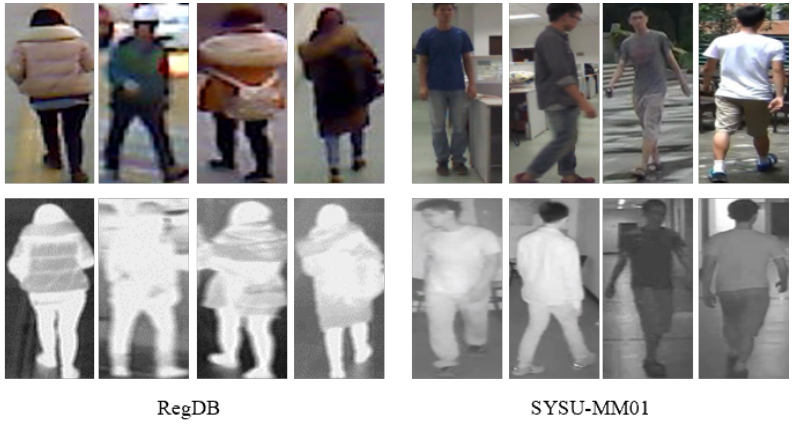
Figure 8. Pedestrian image samples derived from RegDB [78] and SYSU-MM01 [6]. Each col- umn denotes the same ID, and the top row and bottom row represent visible and infrared images,